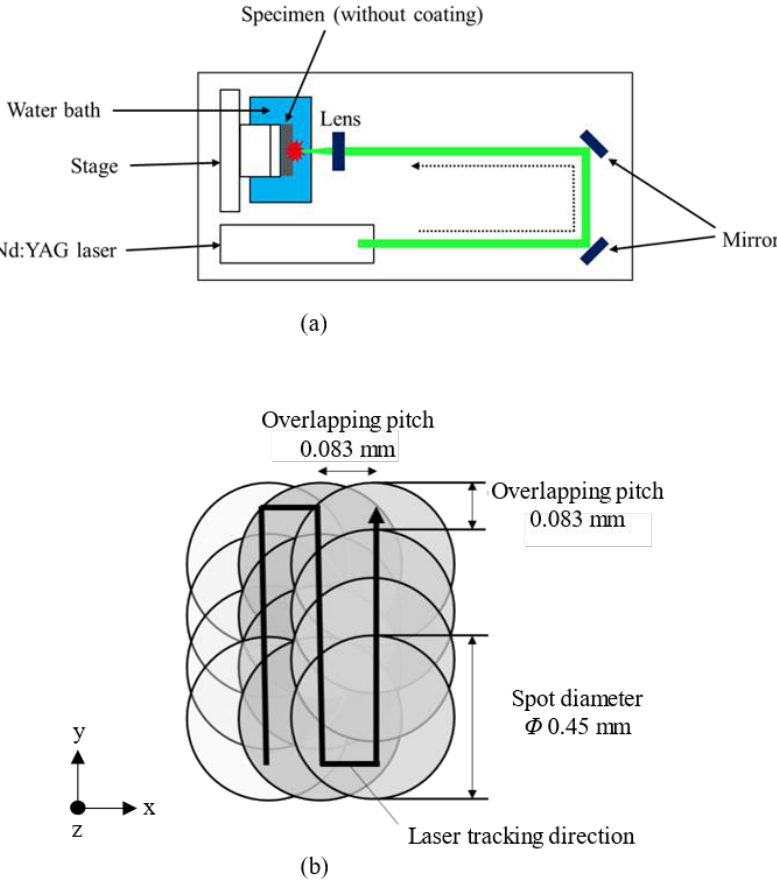
Table 3. Residual-stress measurement conditions.